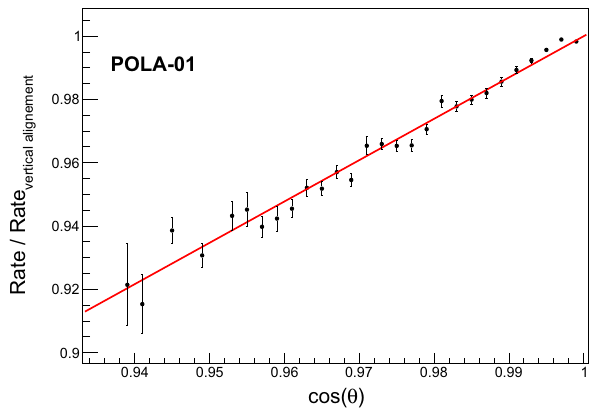
Fig. 2 Cosmic particle rate measured by POLA-01 as a function of atmospheric pressure. An exponential fit, in red, is superimposed to the data (see text)